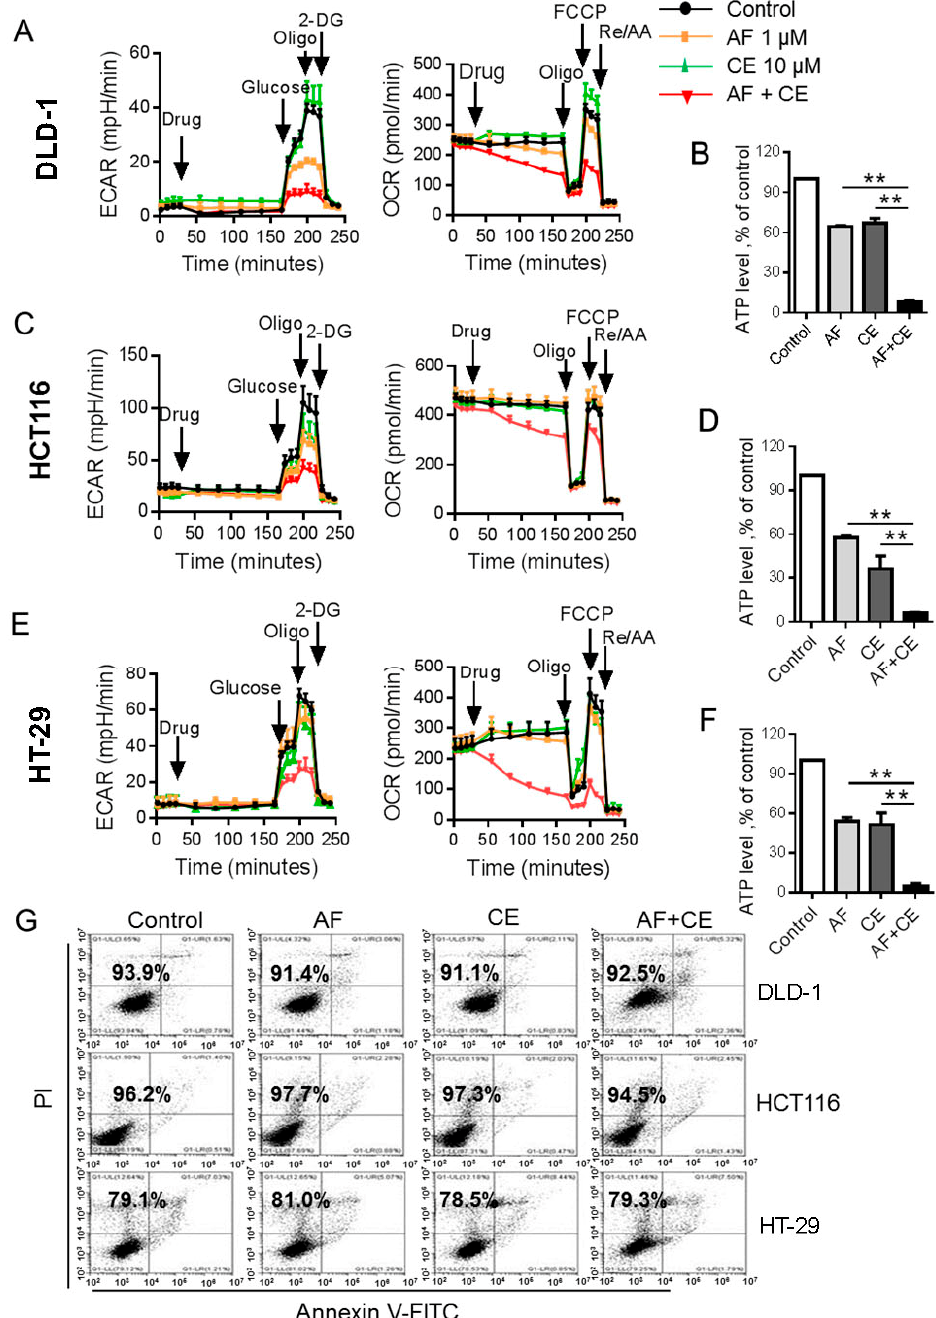
Figure 3. AF / CE combination induced severe energy crisis. ( A , C , E ) Real-time measurement of ECAR and OCR in indicated conditions using the Seahorse Bioscience Extra Cellular Flux Analyzer. For the glycolysis analysis (left panel), cells were sequentially treated with vehicle or drugs (AF 1 µ M, CE 10 µ M, and AF 1 µ M + CE 10 µ M), glucose (10 mM), oligomycin (O, 1 µ M), 2-DG (1 µ M). For the mitochondrial function analysis (left panel), cells were sequentially treated with vehicle or drugs (AF 1 µ M, CE 10 µ M, and AF 1 µ M + CE 10 µ M), oligomycin (O, 1 µ M), FCCP (F, 1 µ M) and rotenone / antimycin A (R / A, 0.5 µ M). ( B , D , F ) Quantitative bar graph of intracellular ATP from three separate experiments after cells treated with AF (1 µ M), CE (10 µ M) and their combination (AF + CE) for 24 h. Percent ATP was calculated relative to untreated cells (set to 100%). Each bar represents mean ± SD, n = 3 separate experiments; ** p < 0.01 ( G ) DLD-1, HCT116 and HT-29 cells were treated with AF (1 µ M), CE (10 µ M) and their combination for 24 h. Cytotoxicity was determined by annexin V / PI assay.